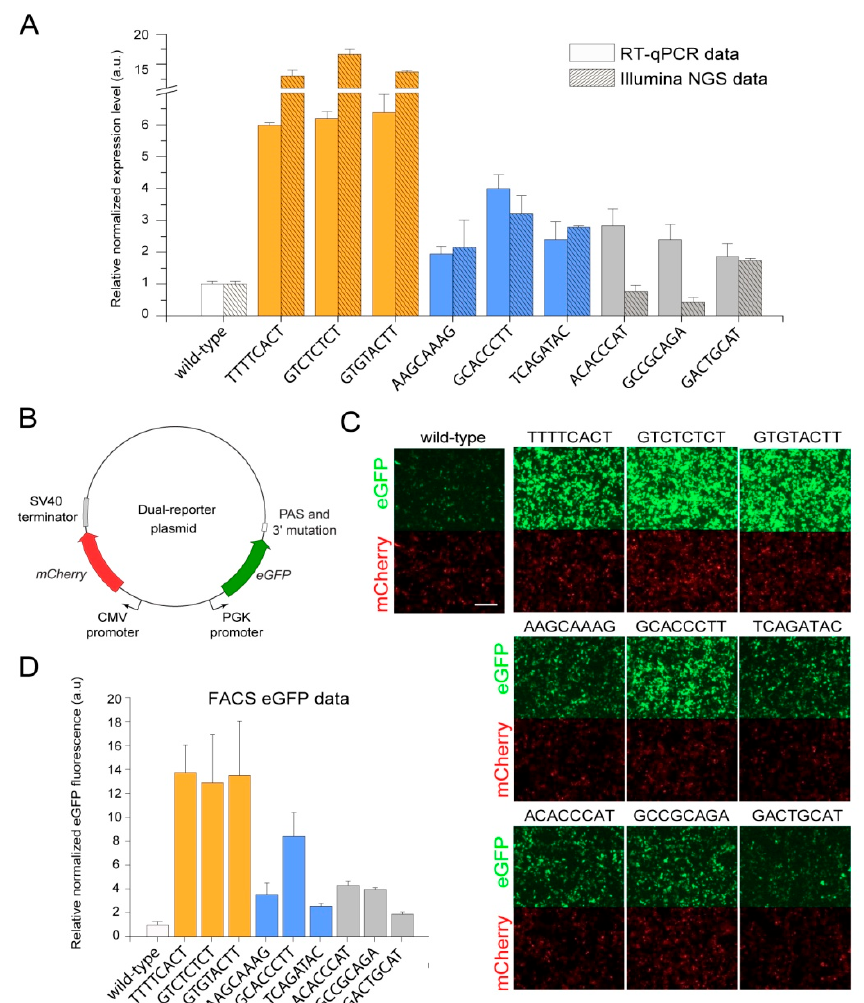
Figure 6. Validation of the positive effects of several chosen mutations identified in the MPRA screening on eGFP expression at the transcript and protein levels in HEK293T cells. ( A ) Comparison of eGFP expression data obtained for individual mutations using RT ‐ qPCR with data obtained using Illumina NGS. Both types of data were normalized by the expression level of the wildtype reference construct. ( B ) The scheme of the dual ‐ reporter plasmid used to test individual mutations. ( C ) Microscopy detection of eGFP and mCherry fluorescence intensities in HEK293T cells transiently transfected with the plasmids bearing the indicated individual mutations. Scale bar, 50 µ m. ( D ) Flow cytometry analysis of the eGFP protein expression in HEK293T cells transiently transfected with the plasmids bearing the indicated individual mutations.